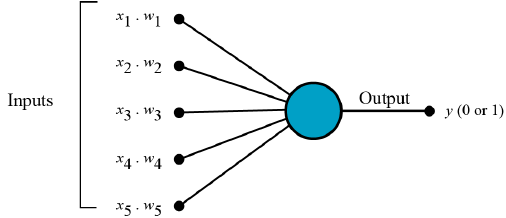
Figure 2. Basic representation of a perceptron. Source: [44].